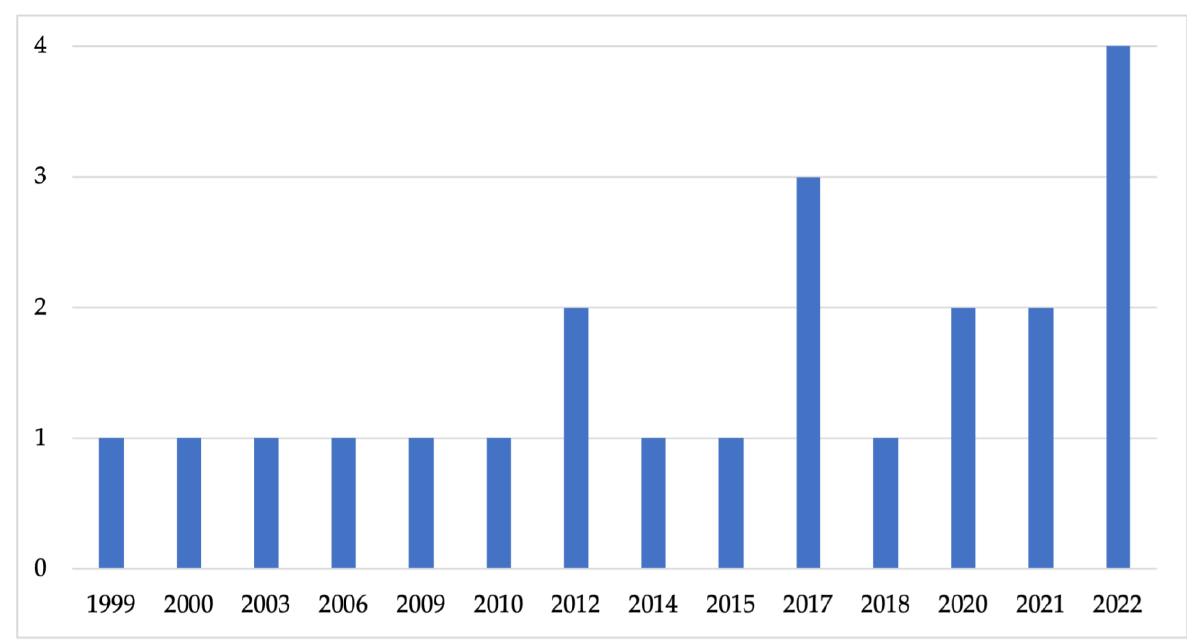
Figure 2. Publication years.